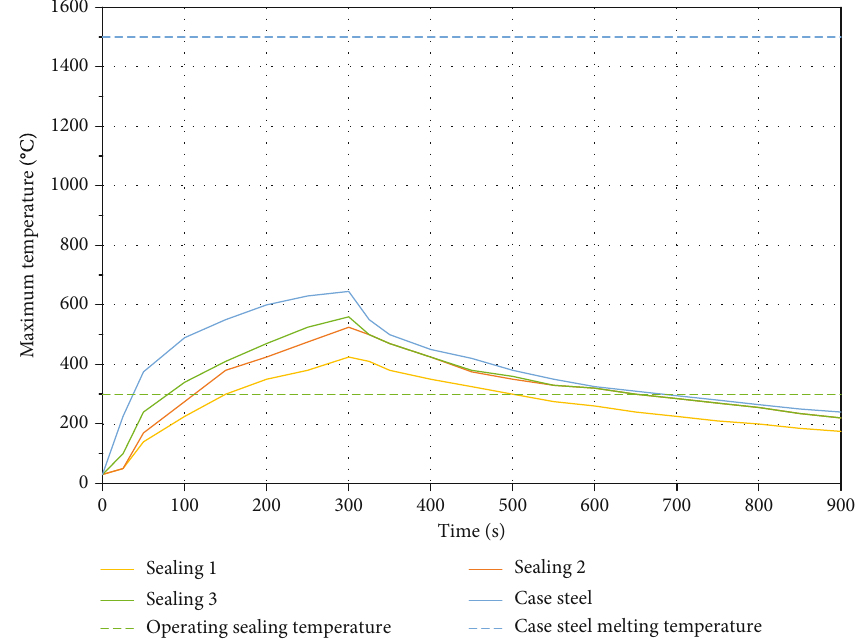
Figure 8: Dependence of maximum temperatures in material on time.